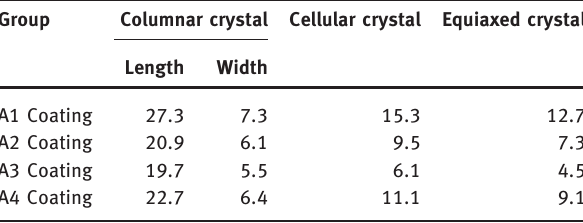
Table 6: Average size of primary crystallisation ( μ m).